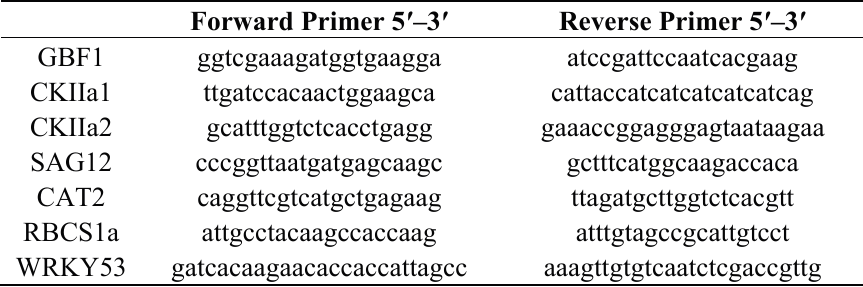
Table 1. Primers used for